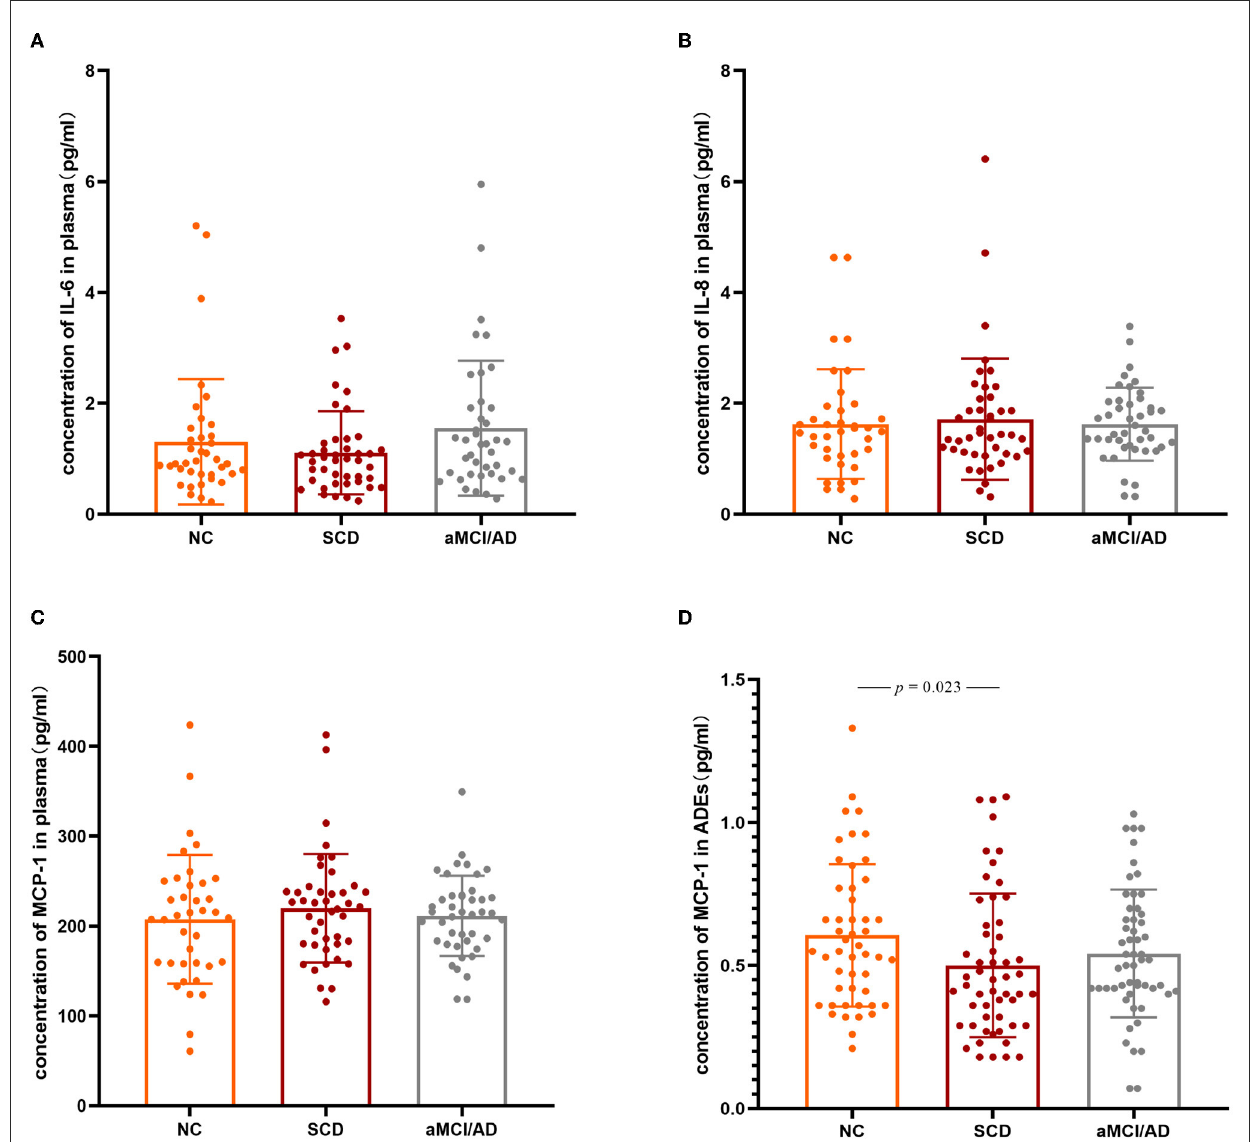
FIGURE2 Three inflammation factors in the NC, SCD, and aMCI/AD groups. The scatter plots with SD present the concentrations of plasma IL-6 (A) , IL-8 (B) , MCP-1 (C) , and MCP-1 levels in ADEs (after normalized with CD81) (D) in different clinical groups. The statistically significant p -values were marked. IL-6, Interleukin-6; IL-8, Interleukin-8; MCP-1, monocyte chemoattractant protein-1; NC, normal controls; SCD, subjective cognitive decline; aMCI, amnestic mild cognitive impairment; AD, Alzheimer’s